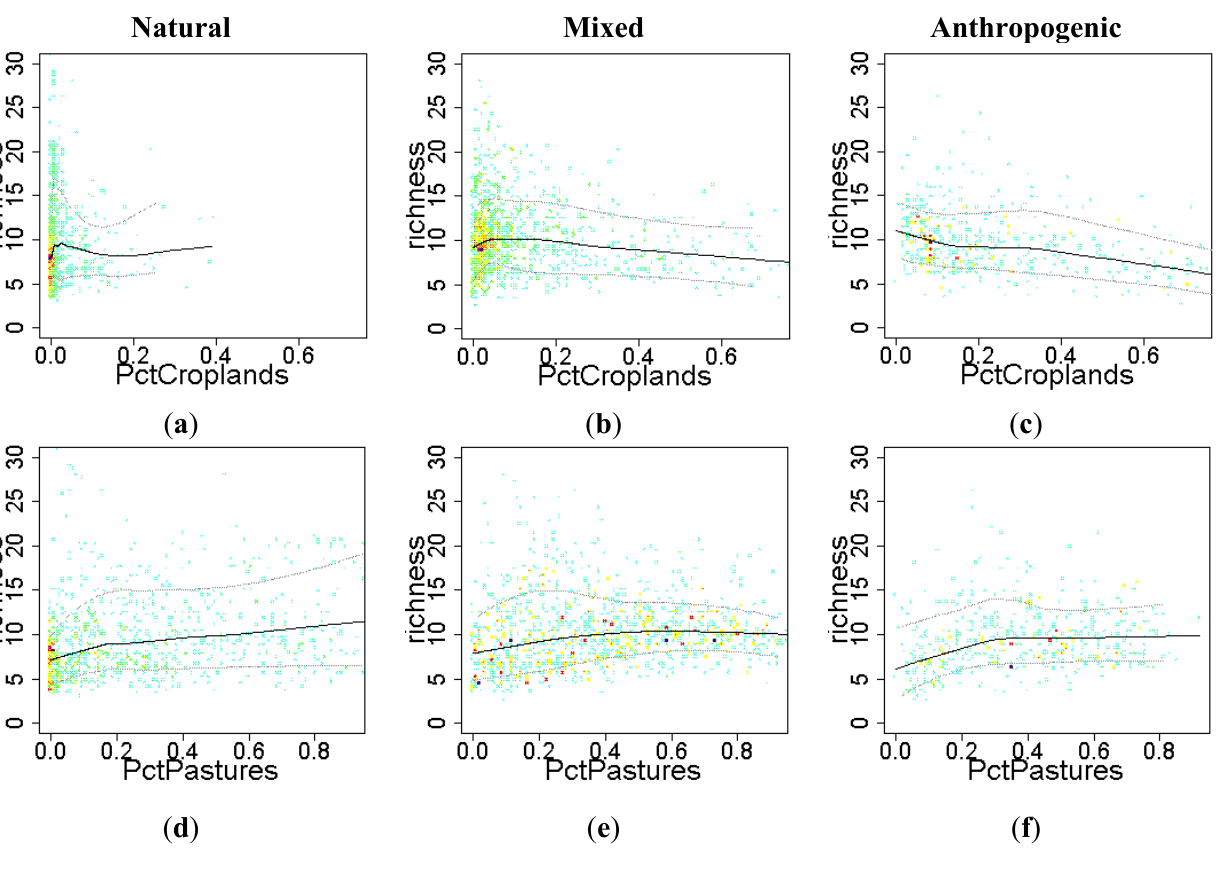
Figure 8. Relationship between the EFT richness and “human influence” variables. To visualize the sense of the effect, we used warmer colors for high point density and Local Polynomial Regression Fitting (LOESS) on the 10th, 50th and 90th percentiles. Relationships were compared across a gradient of Human Influence Index (HII): Natural ecosystems (HII < 10), mixed (10 < HII < 20) and anthropogenic systems (HII > 20). CV: spatial coefficient of variation; Pct: